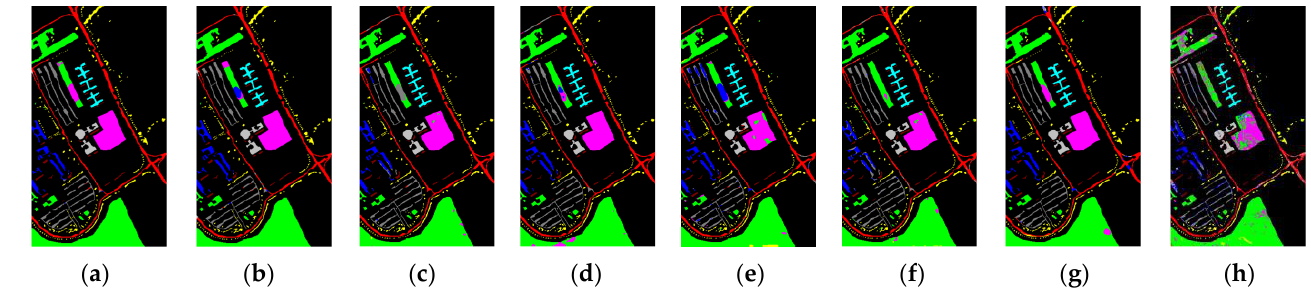
Figure 27. Classification maps using different methods on the Pavia University dataset: ( a ) SCL–MSR;